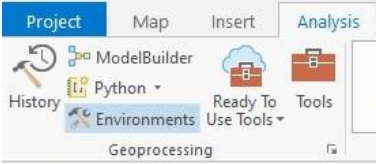
Figure A1. Geoprocessing environments can be found under the Analysis tab in ArcGIS Pro.